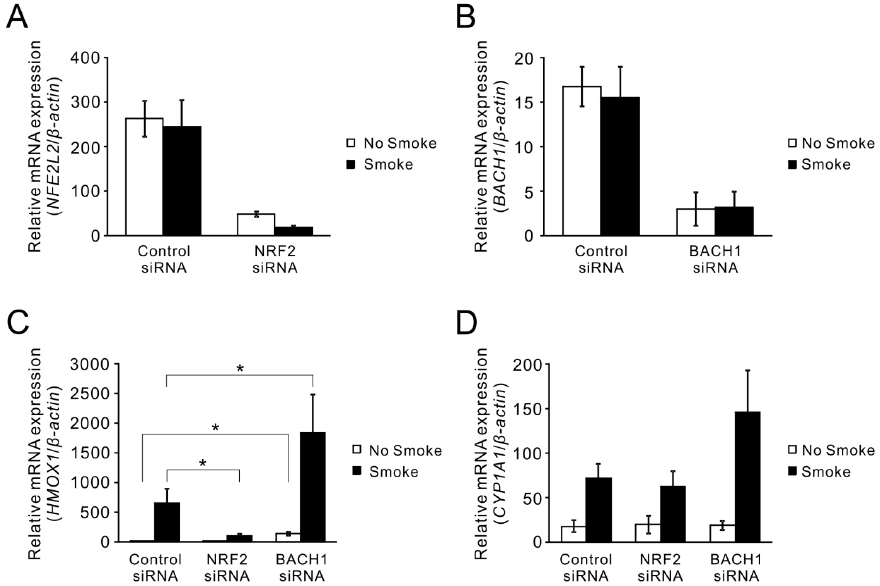
Figure 4. Effects of NRF2 and BACH1 on the induction of HO-1 by cigarette smoke. HBE1 cells were transfected with control non-specific or gene-specific siRNA. After 48 h of transfection, these cells were exposed to smoke extract for additional 24 h and then subjected to qRT-PCR. ( A , B ) Cells were transfected with siRNA targeting NRF2 and BACH1. The knockdown efficiency of NRF2 siRNA assessed by qRT-PCR was 81% in air exposed cells and 92% in smoke exposed cells ( A ); in BACH1 siRNA treatment, the knockdown efficiency was 81% in air exposed cells and 79% in smoke exposed cells ( B ); smoke had no effect on siRNA knockdown. ( C , D ) Cells with siRNA knockdown of NRF2 and BACH1 followed by smoke exposure were subjected to qRT-PCR for HO-1 ( C ) and CYP1A1 ( D ) expression. Results are expressed as the mean across three independent experiments with error bars representing standard errors of measurements (S.E.M.). * p < 0.05.